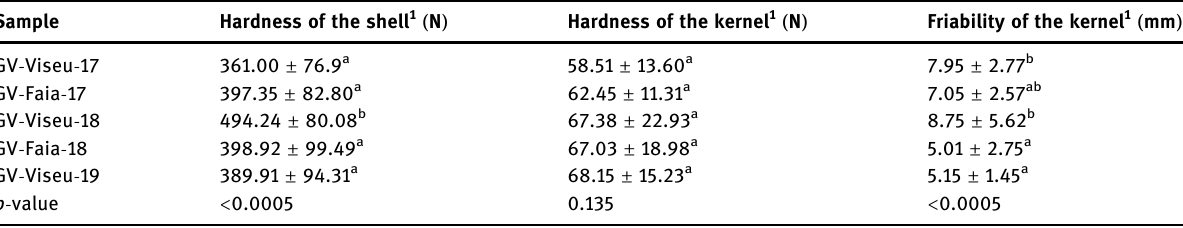
Table 9: Hazelnuts ’ textural properties ( mean ± standard deviation )